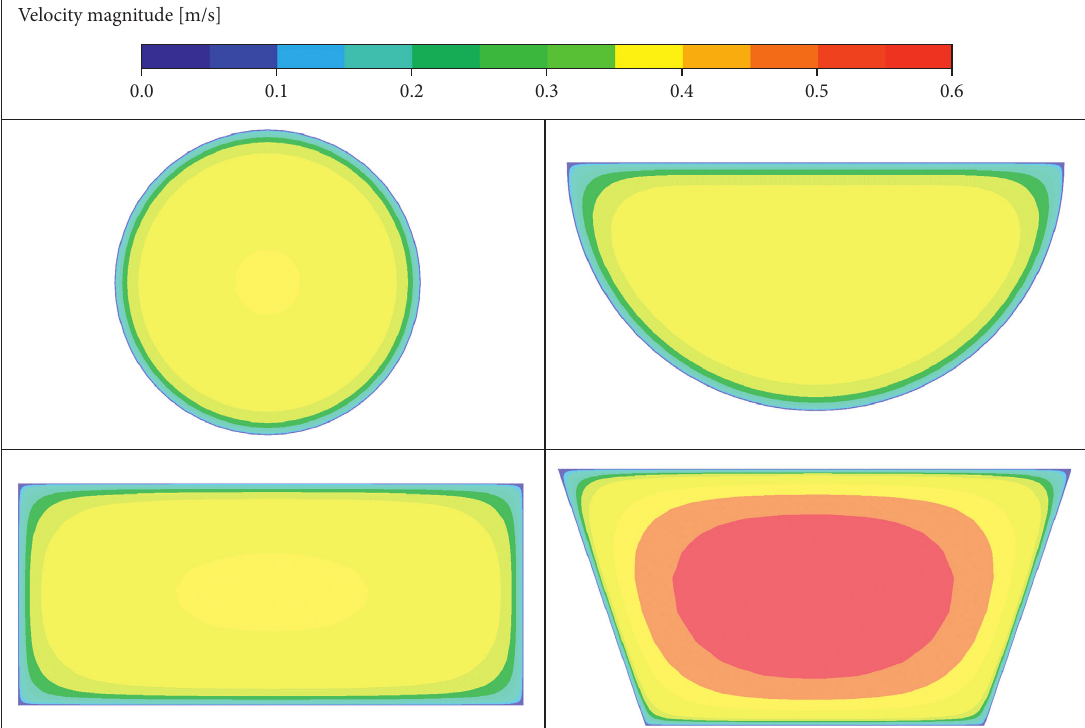
Figure 8: Velocity contours of the channel cross section.